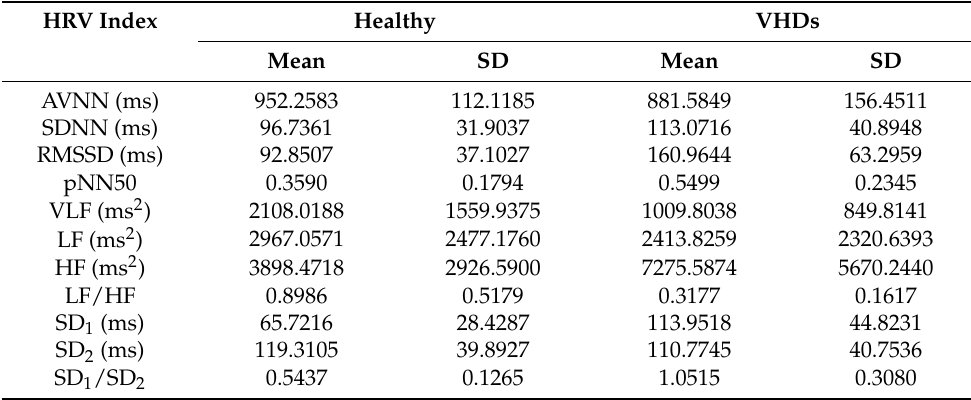
Table 3. HRV indices derived from SCG signals from both datasets.